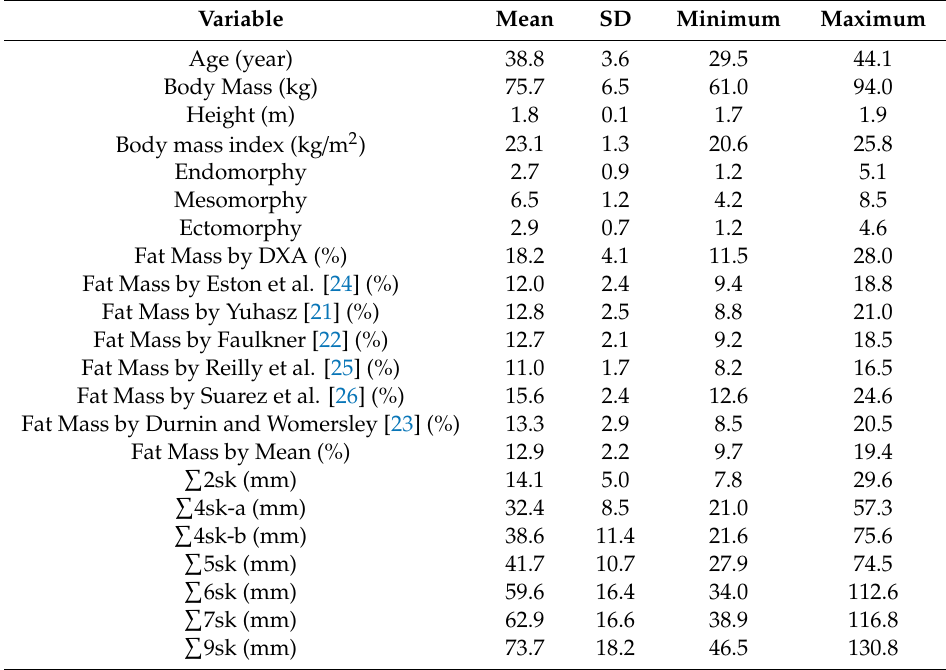
Table 1. General and anthropometric characteristics of the international-level elite referees.